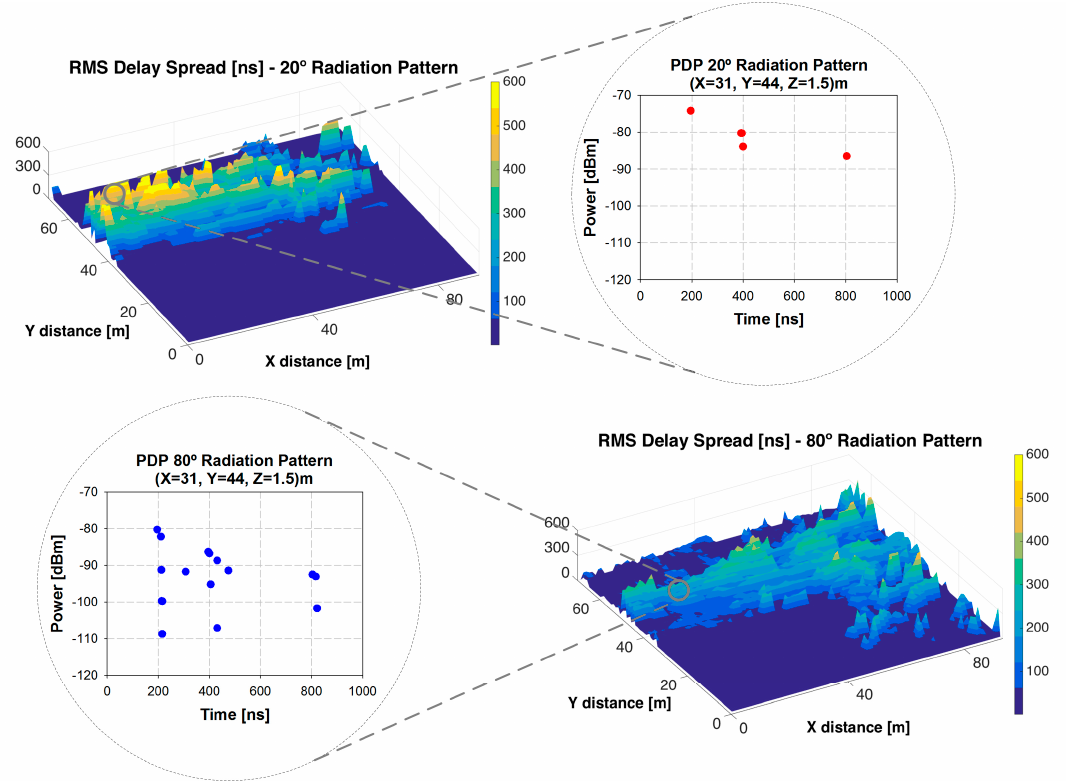
Figure 8. Root-mean-square (RMS) delay spread for 20° and 80° radiation pattern with 180° orientation, for a height of 1.3 m with its associated Power Delay Profile for a specific point in the scenario.